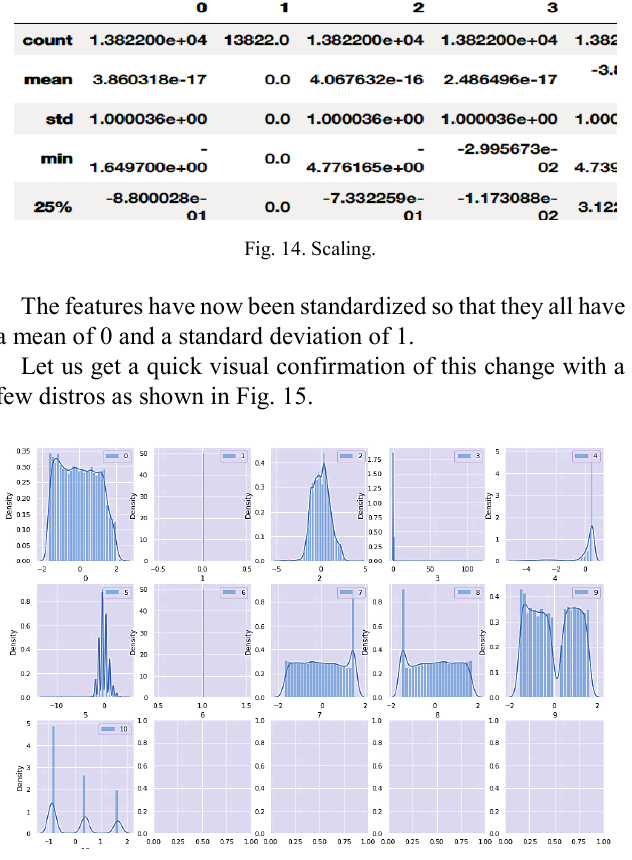
Fig. 15. Column ditribution.